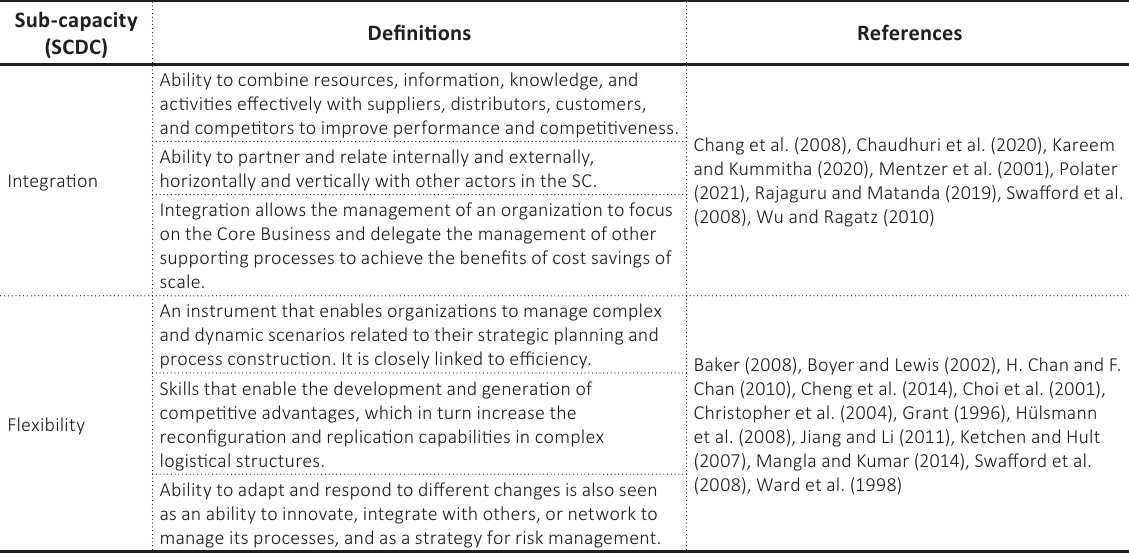
Table 2 (cont.). Definition of main SCDCs